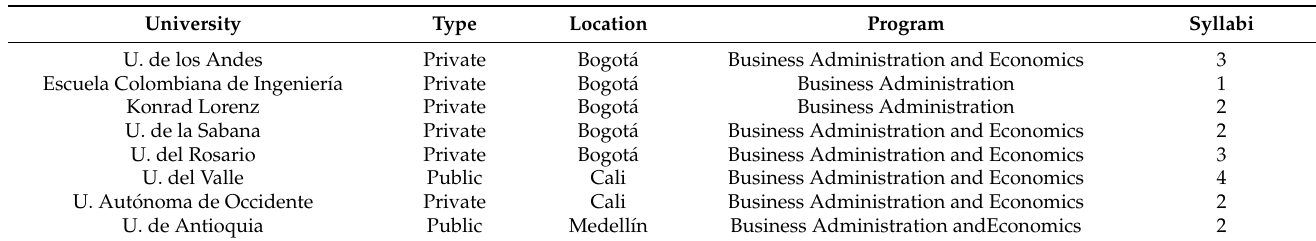
Table 1. Distribution of the syllabi.